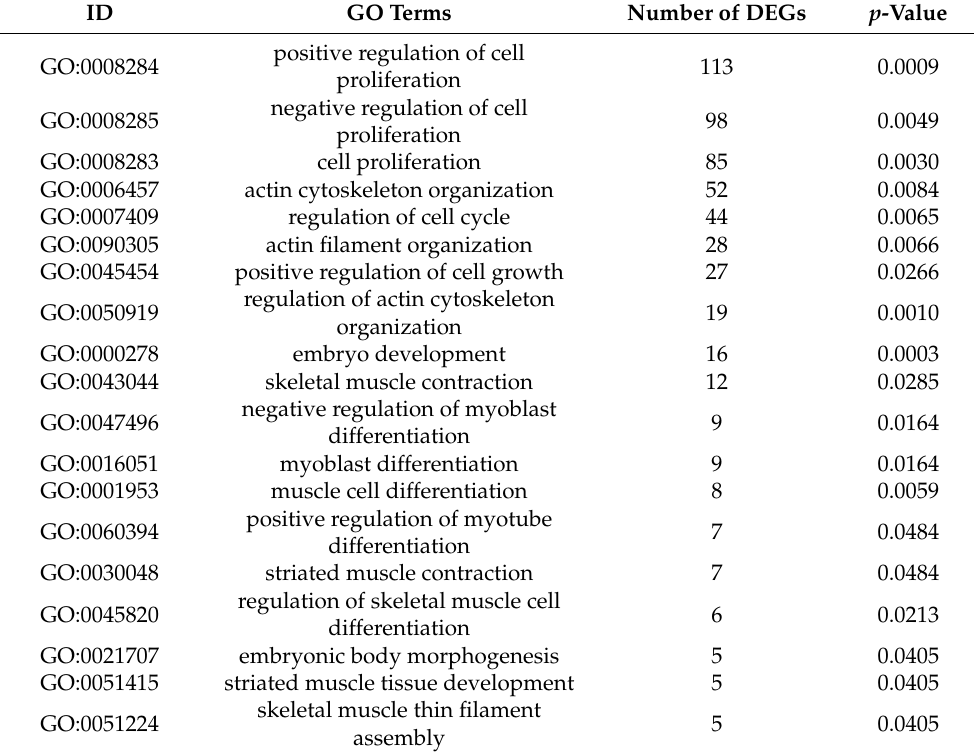
Table 3. GO terms related to the processes of muscle or cell growth and development. ID GO Terms Number of DEGs p